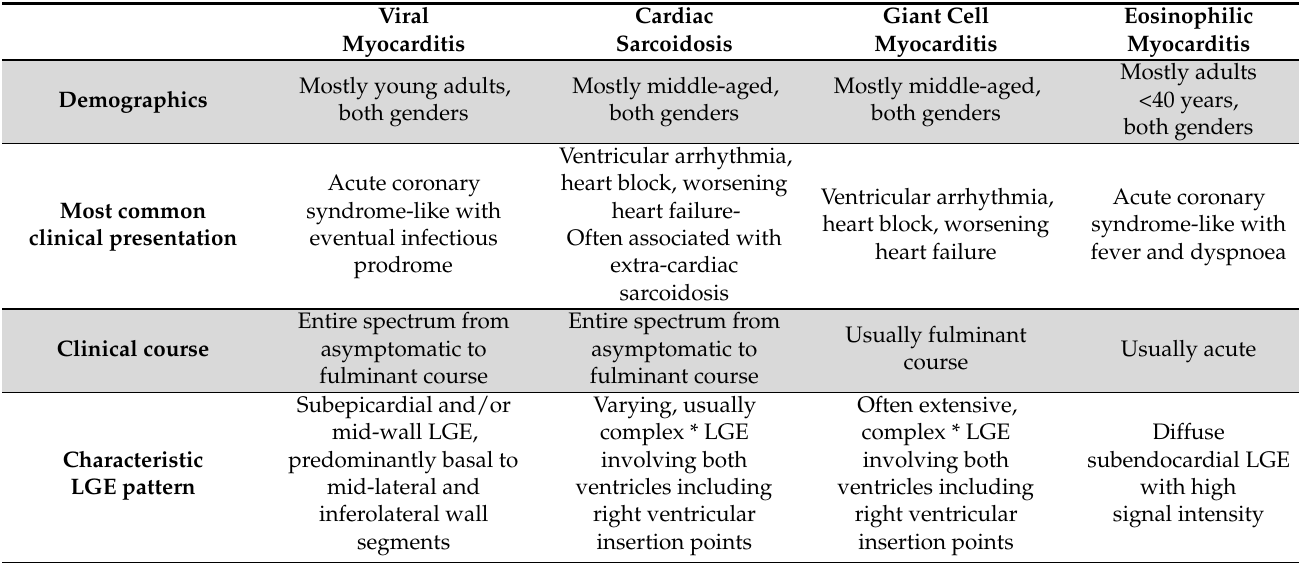
Table 4. Characteristic features of several forms of myocarditis.